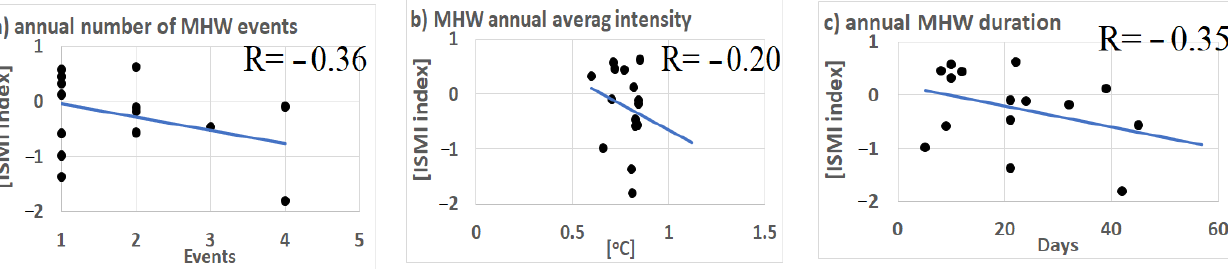
Figure 8. Scatter plots of bi-monthly multivariate ENSO index (MEI.v2) and annual number of MHW events ( a ), MHW annual average intensity ( b ) and annual MHW duration ( c ) during MHW events.